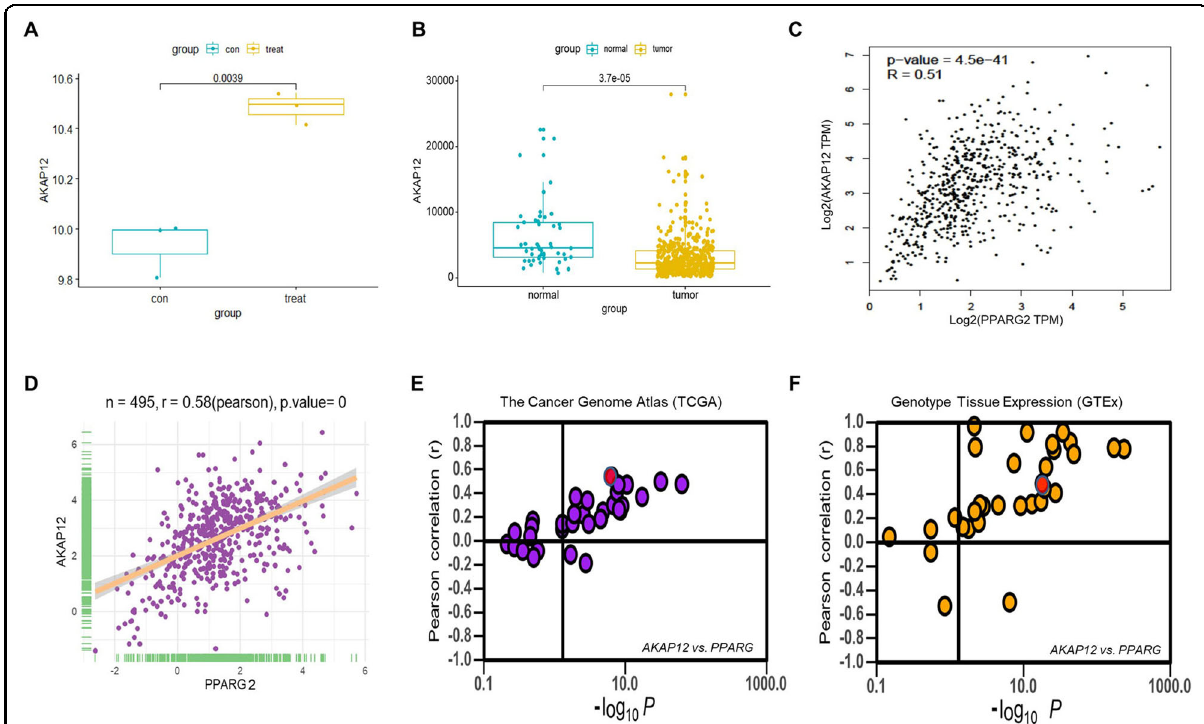
Fig. 5 Positive correlation of AKAP12 in mRNA expression with PPARG2 gene in most cancer or normal tissues. A AKAP12 mRNA expression extracted from the microarray data (EV (con) = 3, PPARG2 (treat) = 3, P = 0.0039). B AKAP12 mRNA expression in PCA patients extracted from TCGA database (normal = 50, tumor = 496, P < 0.001). C , D Correlation of AKAP12 with PPARG2 in expression from GEPIA database ( r = 0.51, P < 0.001) and TCGA database ( r = 0.58, P = 0). E , F Correlation of AKAP12 with PPARG2 in expression in cancer samples from The Cancer Genome Atlas (TCGA database) and normal tissues from Genotype Tissue Expression (GTEx database), respectively. It is noteworthy that every dot represents one cancer type (E) in which the red dot represents PCA tissues ( r = 0.58, P < 0.001) or one tissue type (F) in which the red dot represents prostate tissues ( r = 0.57, P <